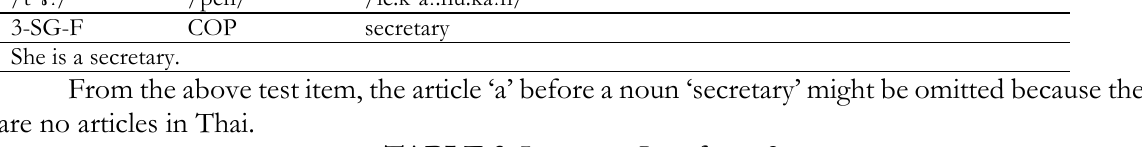
TABLE 3 . Language Interfence 2